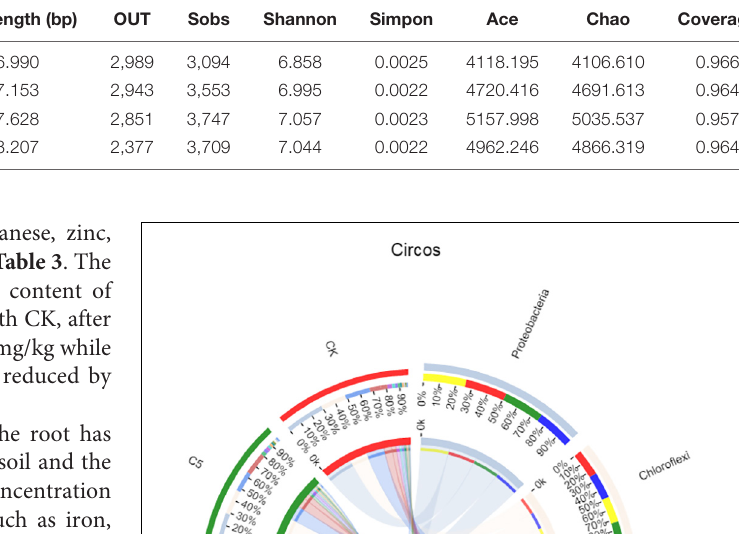
TABLE 4 | Statistics of the trimmed sequences and alpha-diversity of the bacterial communities. Sample Primers Sequence Bases (bp) Mean length (bp) OUT Sobs Shannon Simpon Ace Chao Coverage